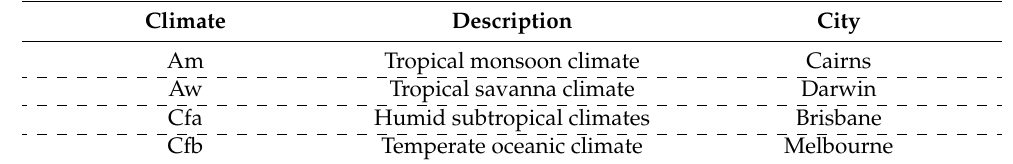
Table 1. Köppen climate zones [51] considered in the paper. Climate: A (tropical), m (monsoon), w (savanna), C (temperate), f (fully humid), a (hot summer), b (warm